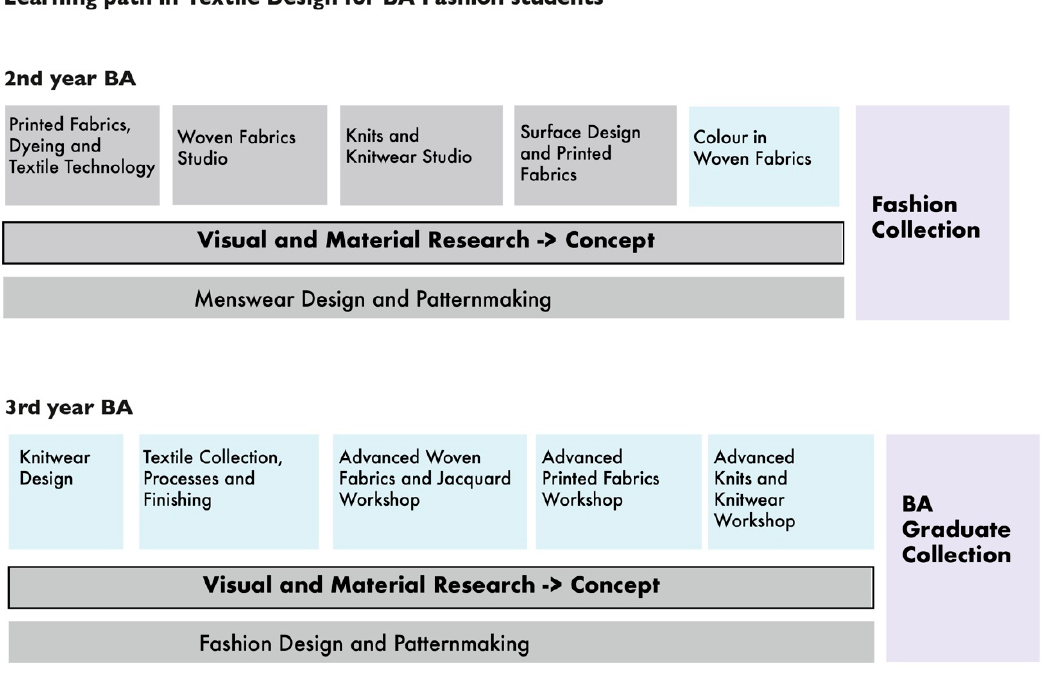
Figure 1. Learning path in Textile Design for BA Fashion students. The chart illustrates the compulsory courses in grey and elective courses in light blue. The courses in fashion design and patternmaking have been simplified to one block for the purpose of this chart (created by author).